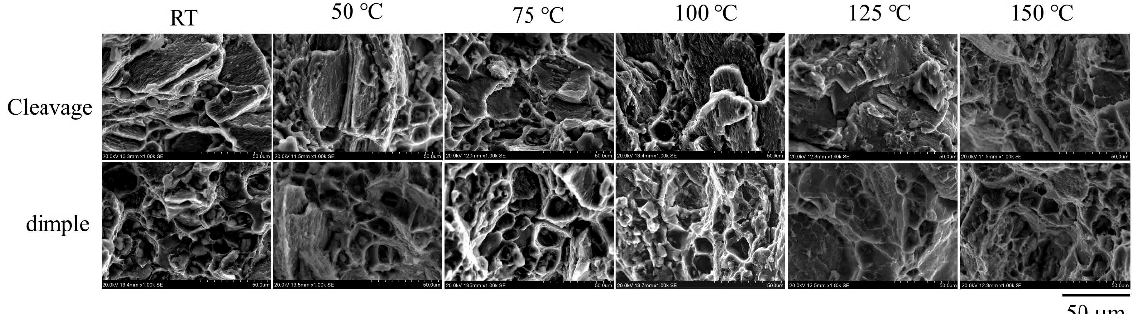
Figure 8. Morphology evolution with temperature of the cleavage structure and the dimple struc- ture.